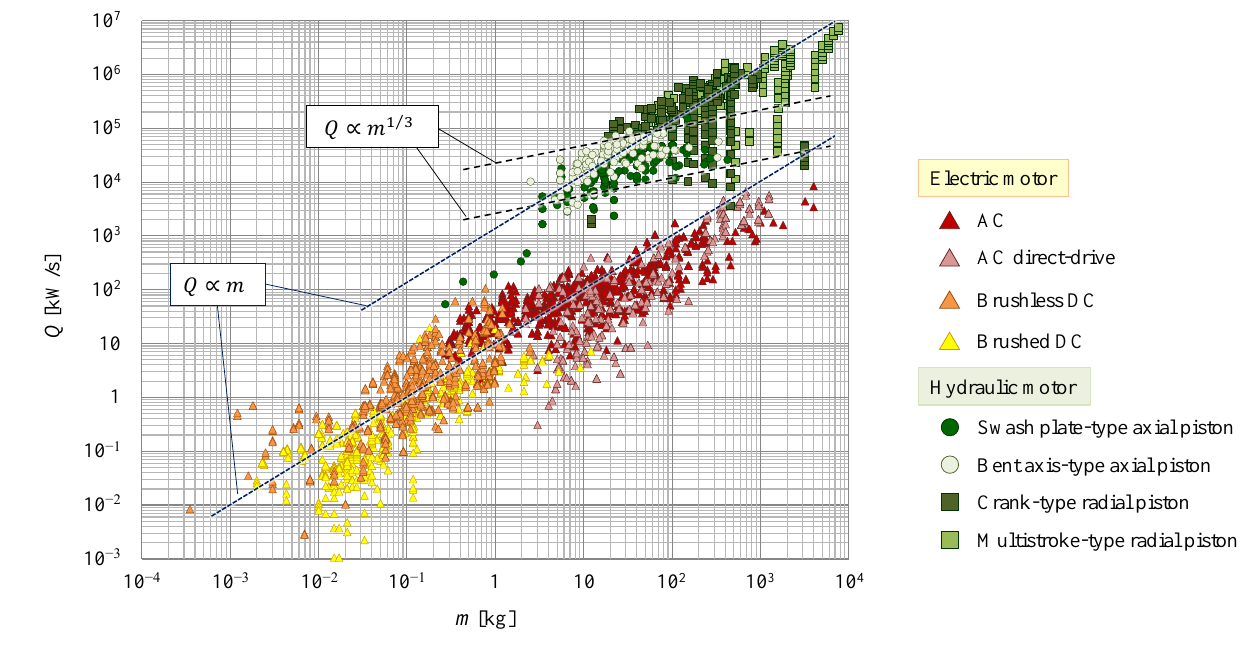
Figure 13. Correlation between motor weight and power rate.